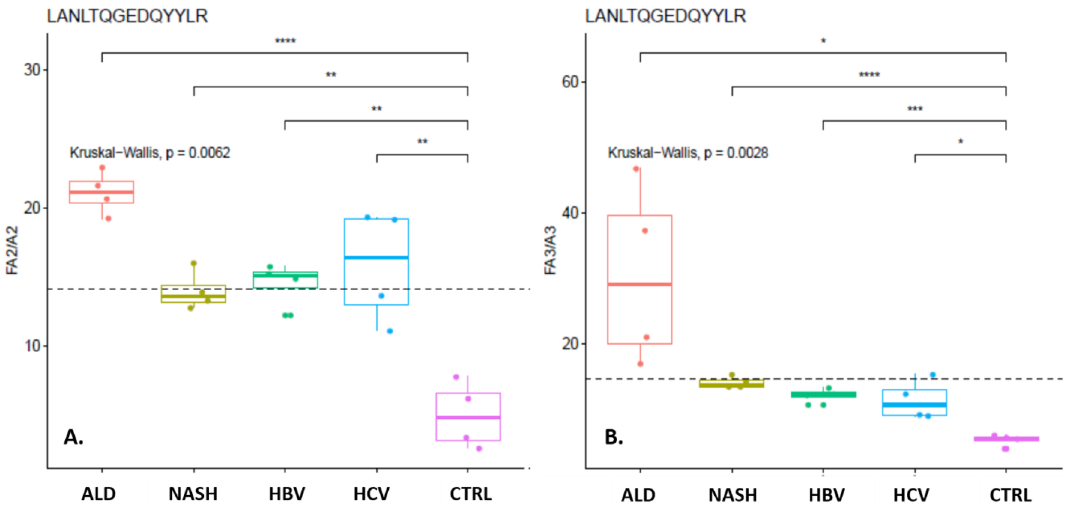
Figure 4. Changes in the relative abundance of the ( A ) bi-antennary and ( B ) tri-antennary core fucosylated glycoforms of the LANTQGEDQYYLR peptide of clusterin in healthy controls and patients with liver cirrhosis of the indicated etiologies. Statistical significane;* indicates p < 0.05, ** indicates p < 0.01, *** indicates p < 0.005, and **** indicates p <